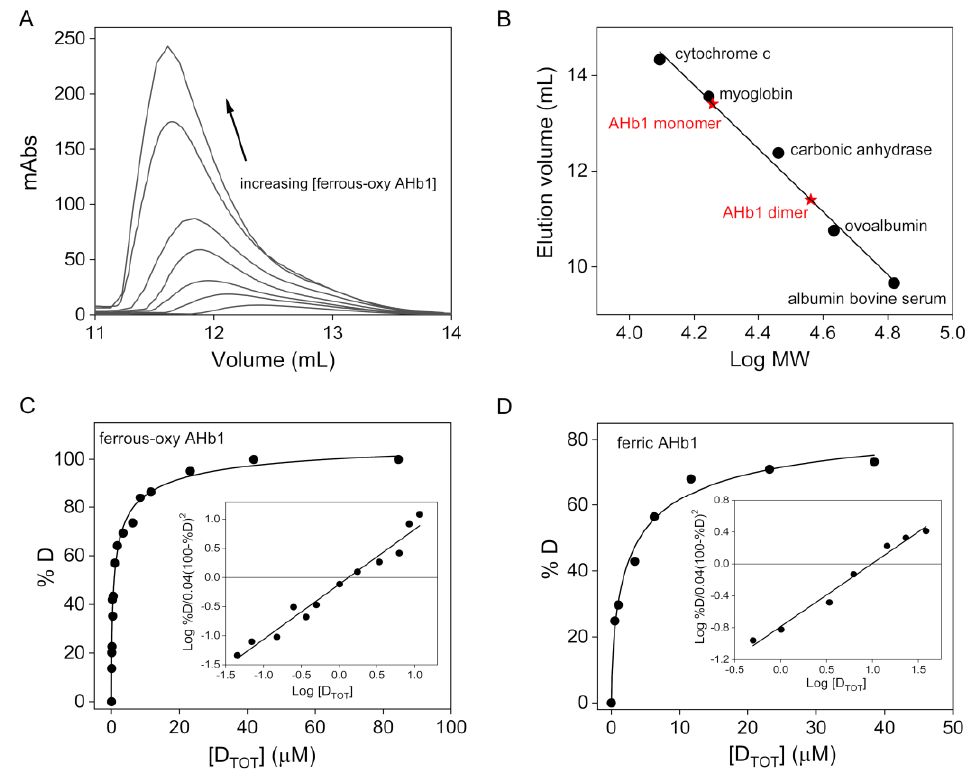
Figure 1. Oligomeric state of AHb1. ( A ) Representative elution profiles of ferrous-oxy AHb1 at selected protein concentrations (70 nM–85 µ M range). The arrow indicates the direction of shift of the chromatographic peak with increasing protein concentration. ( B ) Calibration curve for standard proteins on a Superdex-75 Increase 10 / 300 GL column prepared by plotting the log MW value for each standard versus its corresponding elution volume value. The graph was used to determine the apparent MW of AHb1 monomer and dimer (red five-pointed stars). ( C , D ) Representative dimer-monomer dissociation curves of ferrous-oxy ( C ) and ferric ( D ) AHb1 in 150 mM Tris-acetate buffer, pH 7.5. [D TOT ] represents the total AHb1 concentration (in dimer equivalents) and %D represents the percentage of protein that is actually dimer at various AHb1 concentrations. Inset of C and D shows the plot of log %D / 0.04 (100 − %D) 2 versus log [D TOT ] of ferrous-oxy and ferric AHb1, respectively, according to Manning et al. [28]. Procedures used for evaluation of K d values are described in detail in Section 2.5.